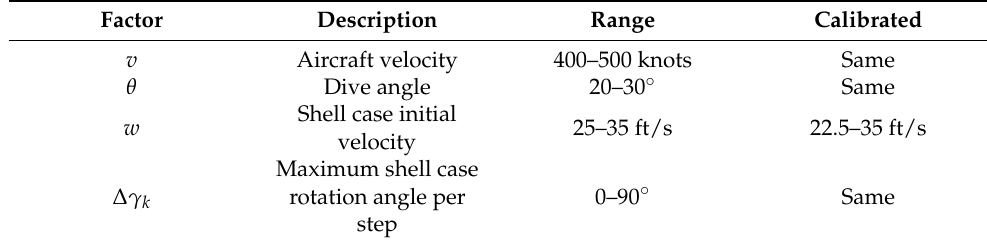
Table 2. Ranges of factors used in sensitivity